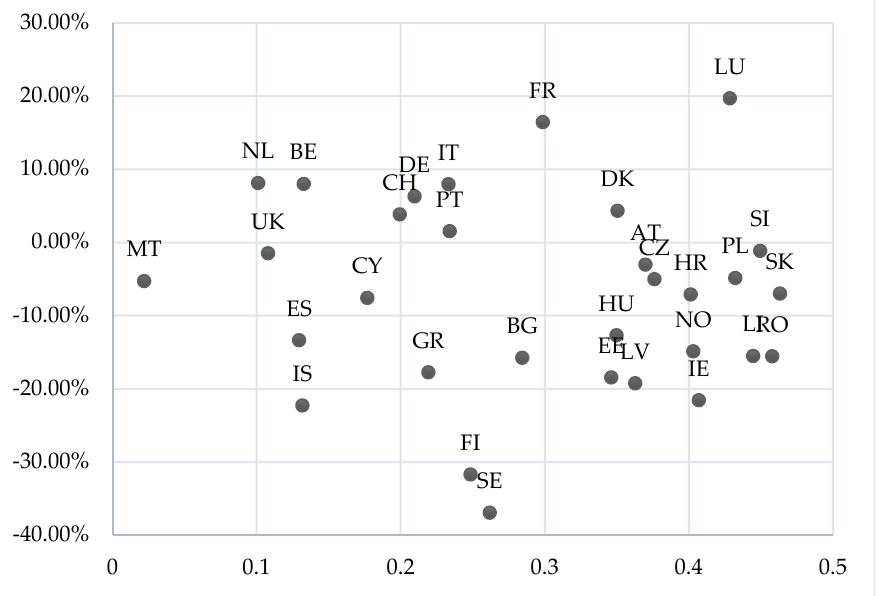
Figure 1. Percentage points of rural youth population relative to total youth population (15–24 years)